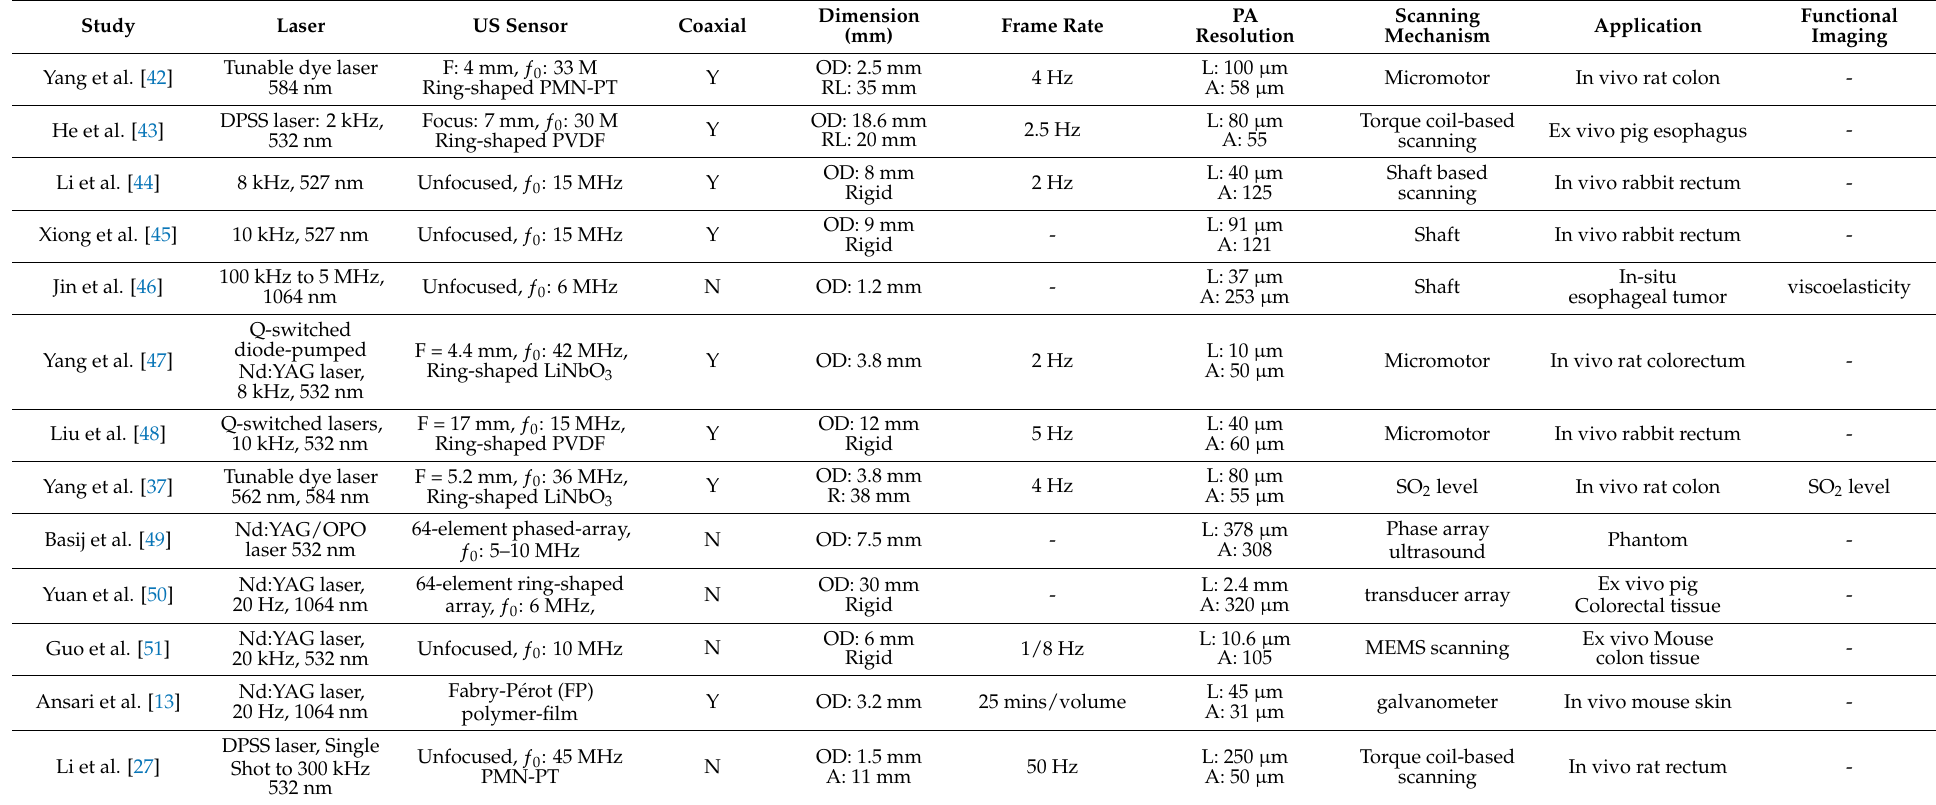
Table 2. Representative endoscopic photoacoustic imaging systems for GI